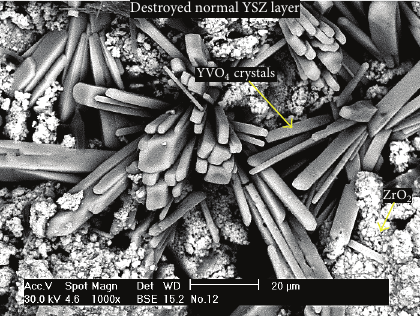
Figure 15: Outward growth of YVO 4 crystals in conventional YSZ